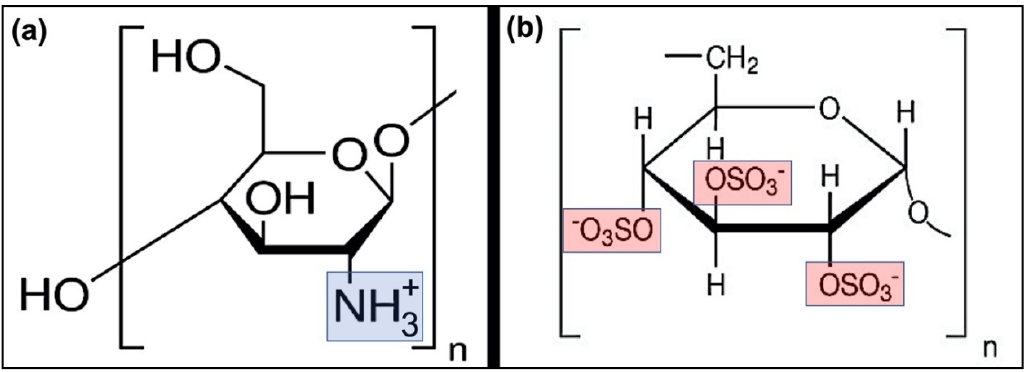
Figure 1. Chemical structures of ( a ) chitosan and ( b ) dextran sulfate with indication of their ionizable groups.